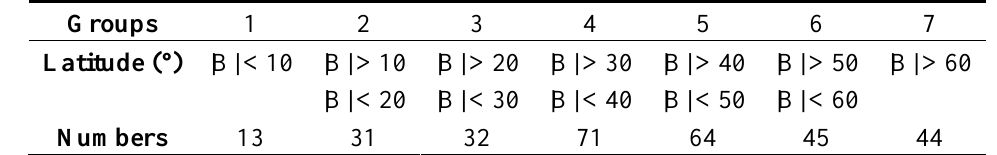
Table 2. 300 IGS Sites’ distribution at different